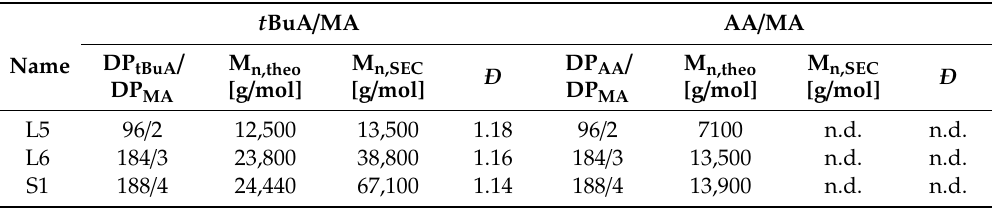
Figure 6. The influence of KCl concentration on the transmittance (% T ) of the L4 solution (0.25% w/w). 3.5. Synthesis and Characterization of Well-Defined AA / MA Copolymers with Di ff erent Topology First, t BuA / MA copolymers were synthesized by ATRP with low dispersity ( Đ = 1.18–1.14). Next, post-polymerization modification of the tert -butyl groups into acidic groups was conducted (Table 2, Scheme 1), and successful acidolysis was confirmed via 1 H NMR spectroscopy. Table 2. Characterization of linear and star-shaped P(AA- co -MA) samples obtained via atom transfer radical polymerization (ATRP) and subsequent